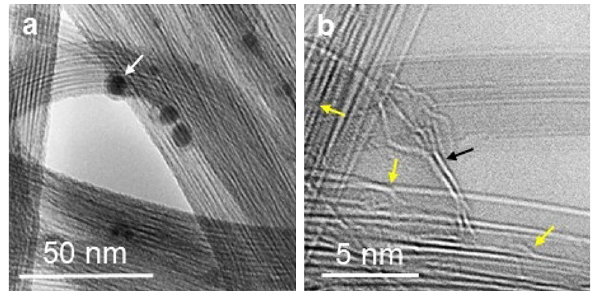
Figure 1. TEM images for Tuball-SWNTs. ( a ) Low magnification. ( b ) HRTEM. The samples coexist with metal catalysts (white arrow in ( a )) as well as graphitic structures (black arrow in ( b